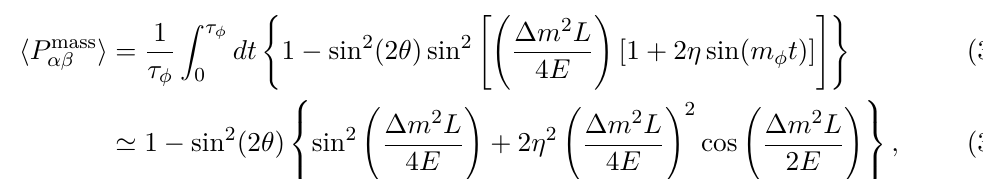
JHEP01(2021)094 = 31